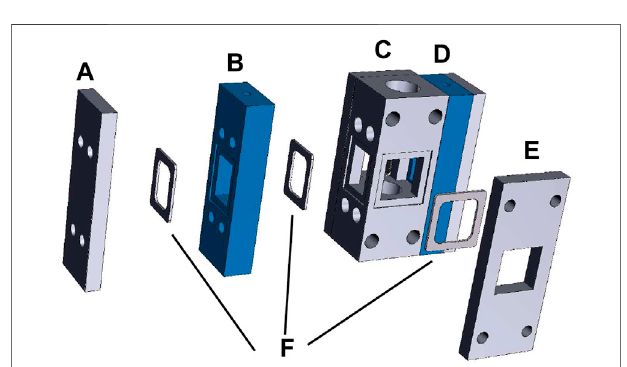
FIGURE 4 | Testing vessel design. (A) Compression plate for anode compartment 1. (B) Anode compartment 1. (C) Cathode compartment. (D) Assembled anode compartment 2. (E) Compression plate for cathode compartment. (F) Gaskets and O-rings to form gas- and liquid- tight